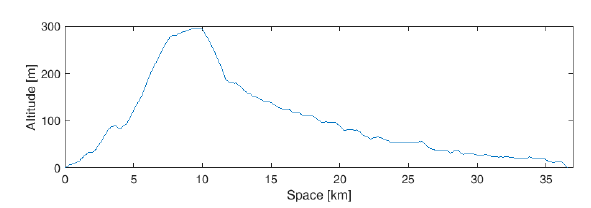
Figure 7. Fast-urban speed profile.